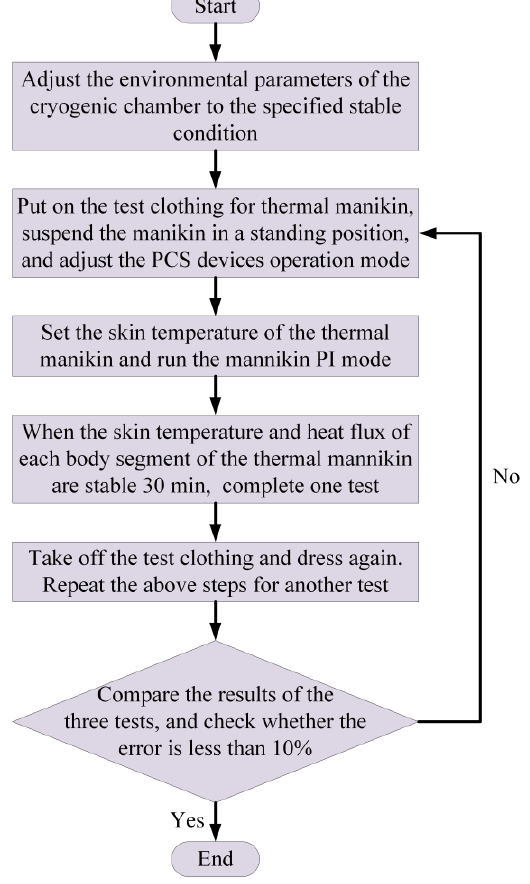
Figure 5. Test procedure.